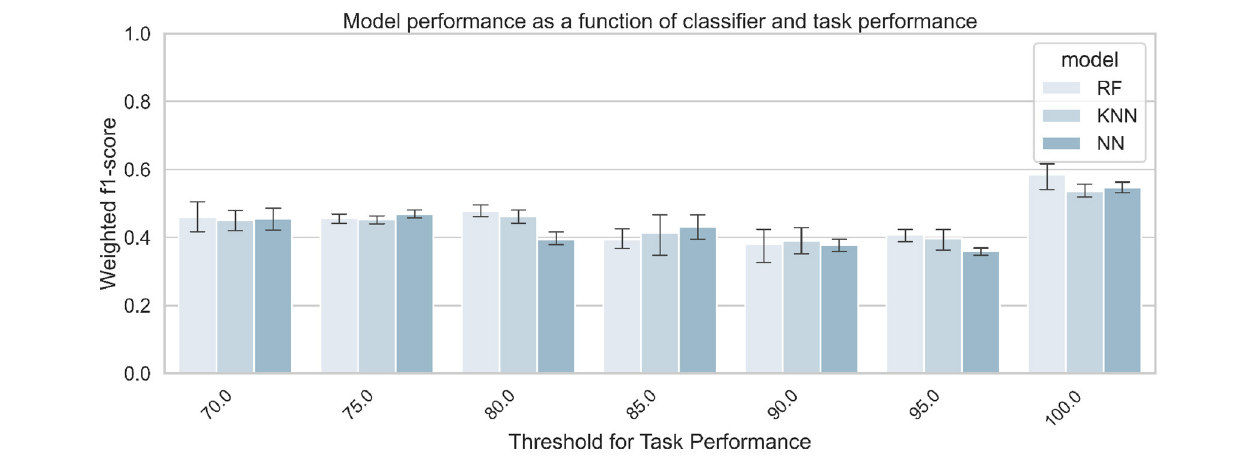
FIGURE 15 | Classification accuracy for predicting task modality (visual vs. auditory), as a function of classifier and task performance. The three signals (EDA + ECG + RESP) were used to train the classifiers.